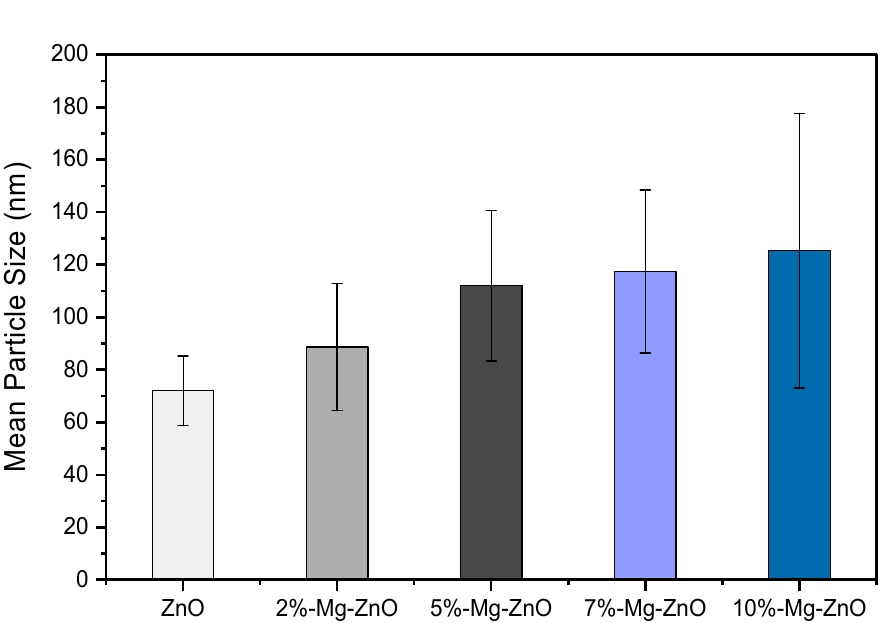
Figure A1. Representative ImageJ analysis of the particle sizes of ZnO and Mg-doped substrates obtained by FE-SEM imaging. Error bars represent the size distributions within each respective sample.